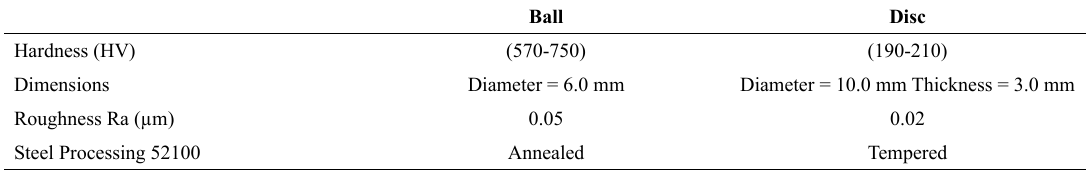
Table 5. The physical characteristics of the tribological pair.